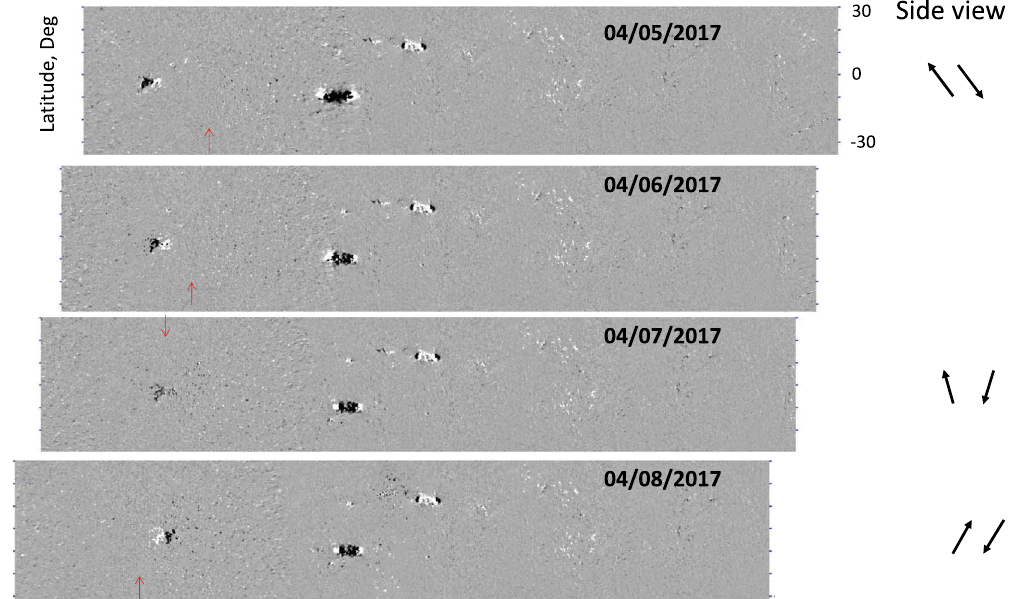
Fig. 3. (Left) Changes in the pattern of the zonal (East – West) vector- fi eld component of a small bipolar region over its disk passage. Four panels show the so-called near real time (NRT) synoptic maps. White/black halftones correspond to magnetic fi eld directed towards the West/ East. Each NRT map covers 360 (cid:1) in longitude (horizontal direction) and approximately ±30 (cid:1) in latitude (vertical direction). The most recent data are added onto the left side of synoptic maps. The dates of the most recent observations added to synoptic map are shown in the upper-right corner of each panel. For visual clarity, the synoptic charts are shifted to have the active regions aligned in the vertical direction. Small red arrows plotted in the left part of each panel correspond to the approximate location of the central meridian for the day of observations. Panels on the right show a schematic inclination pattern of the magnetic fi eld vectors in a vertical East – West oriented plane (as if we were looking at an active region from the side).